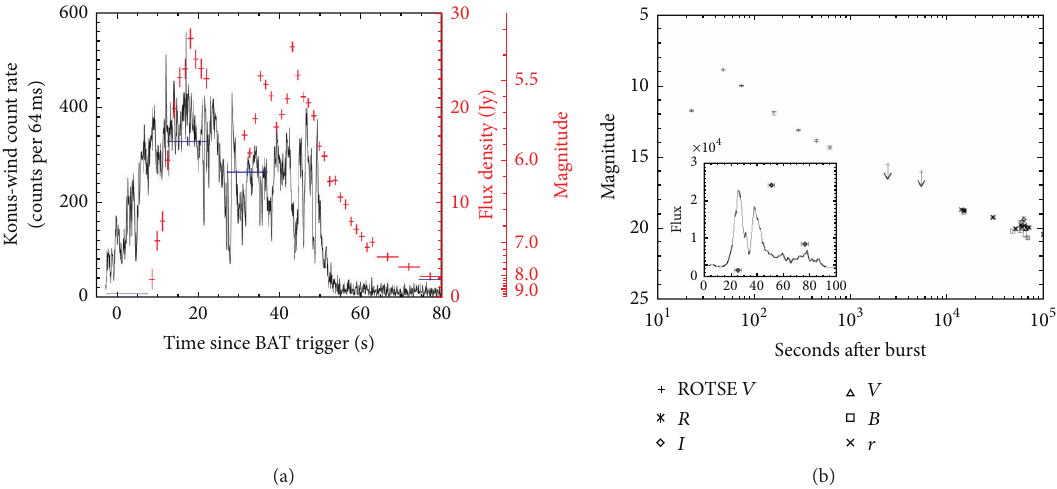
Figure 11: (a) Gamma-ray light curve (black) and optical data from “Pi in the sky” (blue) and “Tortora” (red) of GRB080319B show how the optical component traces the 𝛾 -ray component. Figure taken from Racusin et al. [116]. (b) Gamma-ray and optical light curve of GRB990123 show that the optical light curve lags behind the 𝛾 -rays. Figure taken from Akerlof et al. [117].